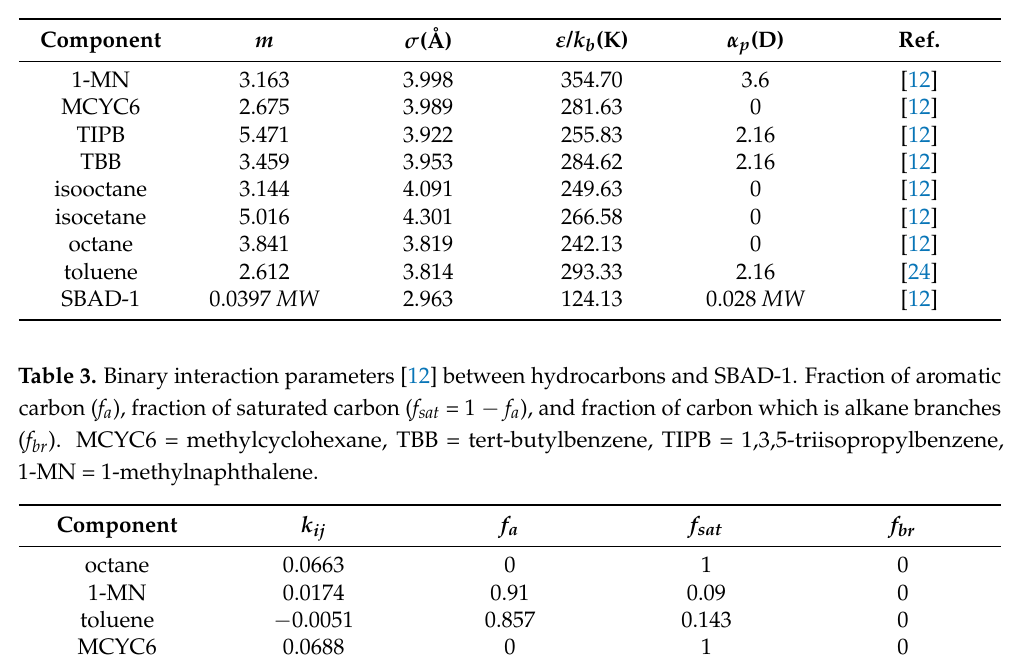
Table 2. Pure component polar PC-SAFT parameters for nine hydrocarbons and SBAD-1. The molecular weight of SBAD-1 is assumed to be MW = 100,000 g/mol. MCYC6 = methylcyclohexane, TBB = tert-butylbenzene, TIPB = 1,3,5-triisopropylbenzene, 1-MN = 1-methylnaphthalene.